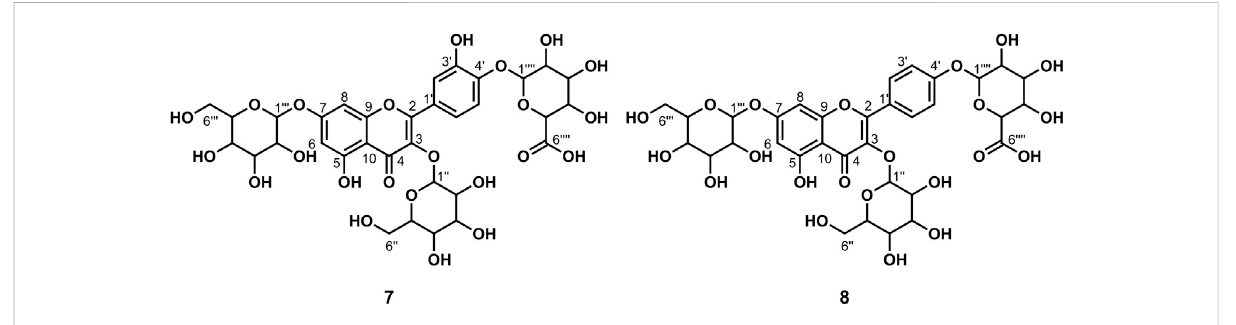
FIGURE 4 Chemical structure of compounds 7 and 8